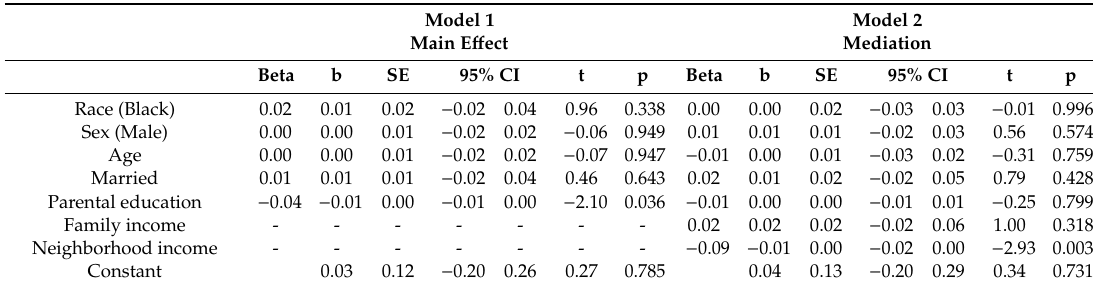
Table 3. Linear regressions (n = 3067).